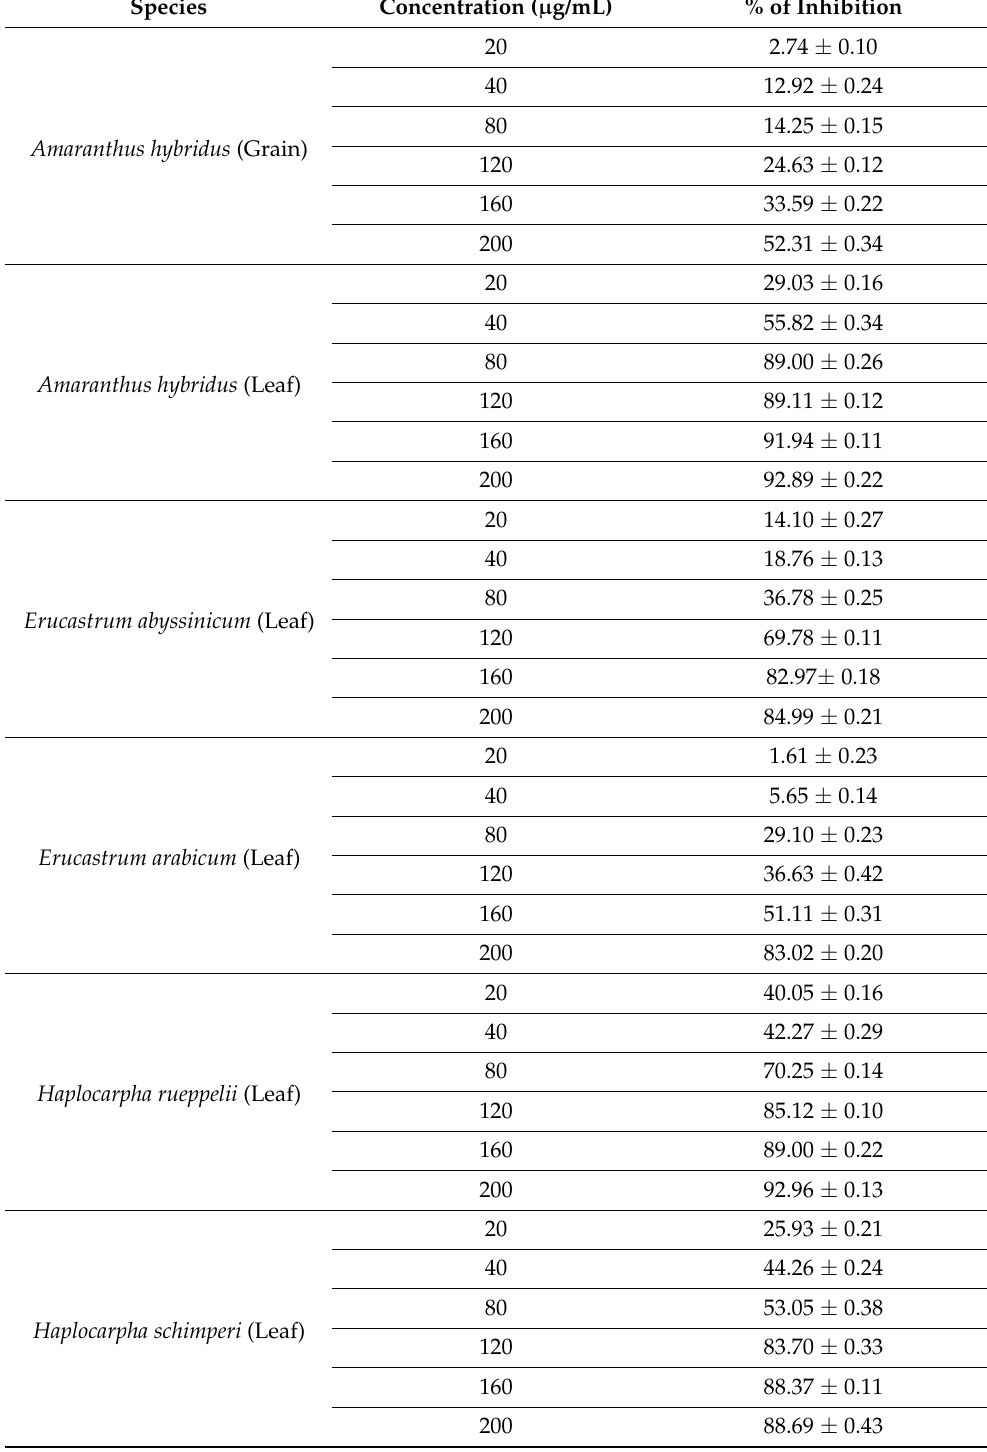
Table 2. DPPH free radical scavenging activities of selected wild edible